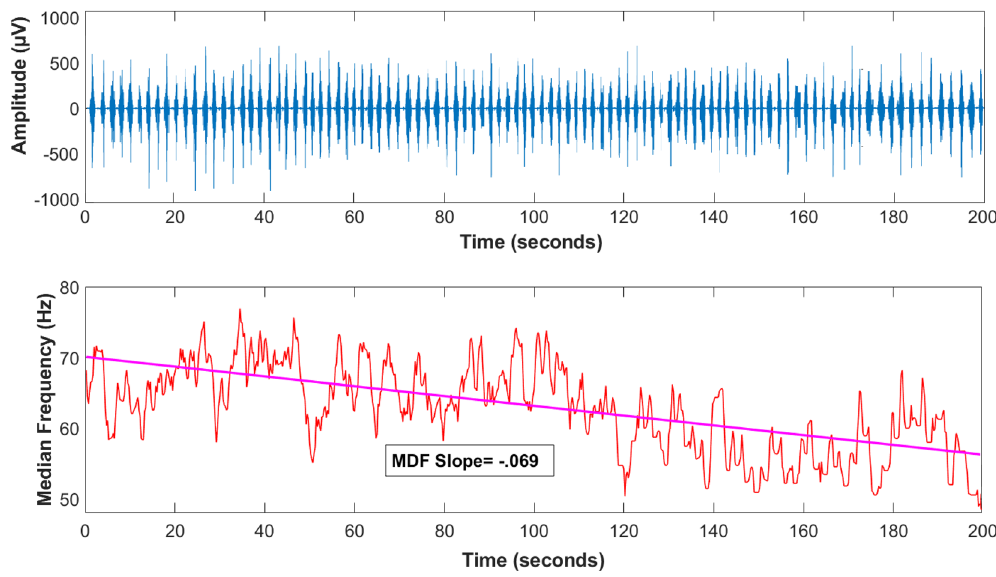
Figure 3. EMG Parameters. (top) Sample of electromyography activity, and (bottom) median frequency (STFT) of Rectus Femoris muscle during the fatigue